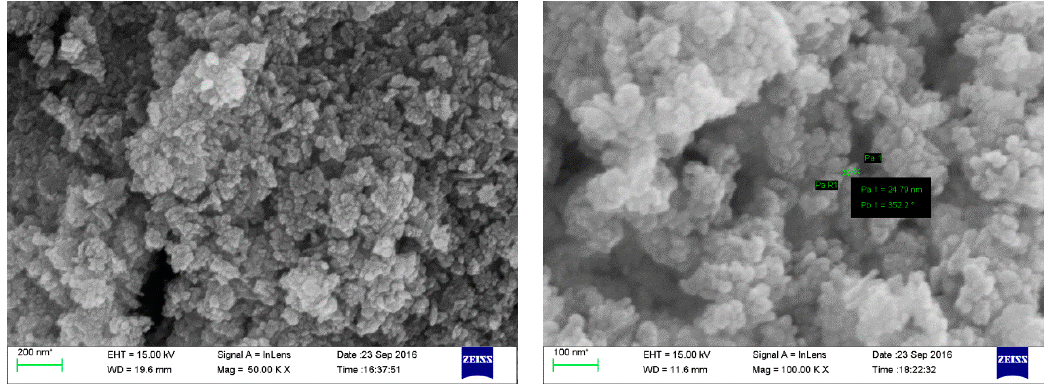
Figure 7. SEM images of nano-ZnO.